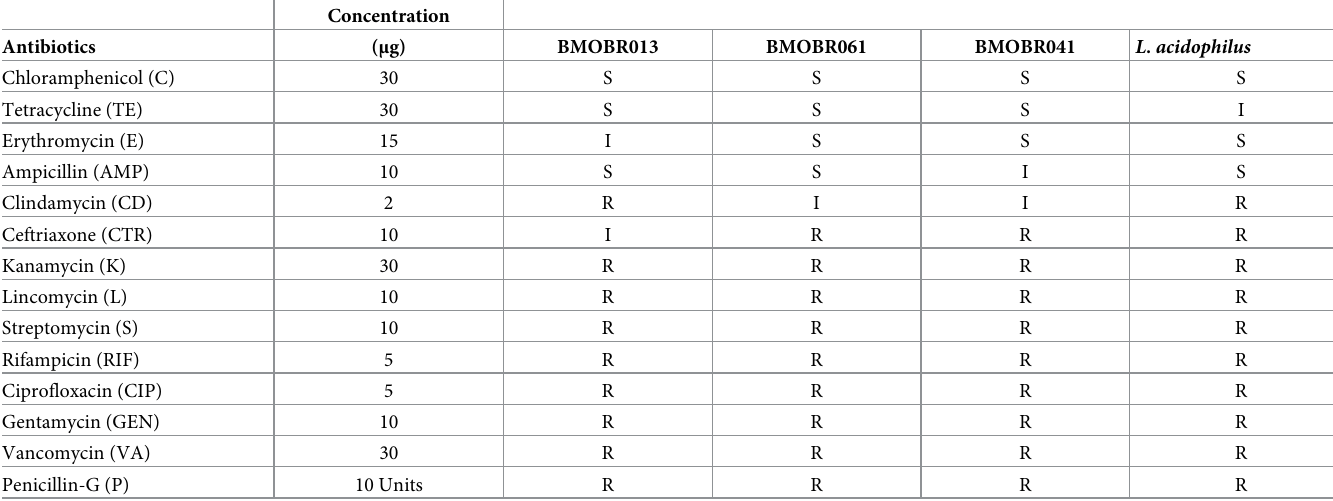
Table 2. Antibiotic sensitivity of three LAB isolates using disc diffusion